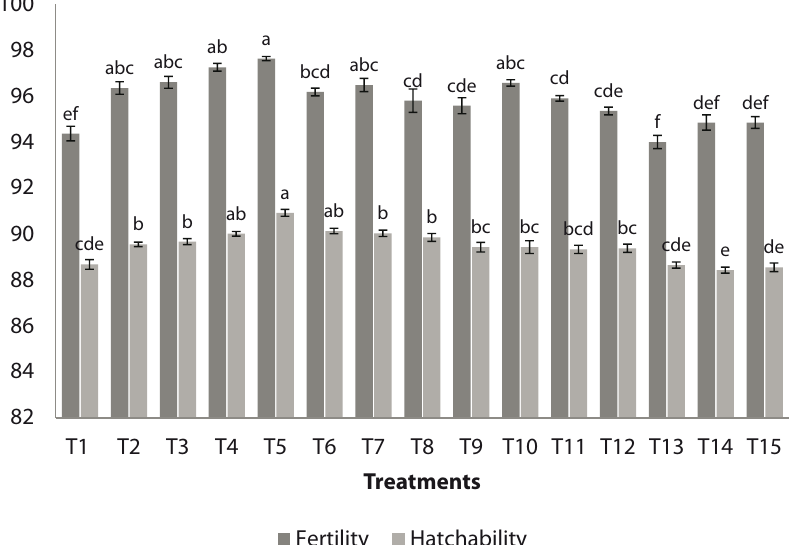
Treatments Fertility Hatchability For both fertility and hatchability, different letters indicate significant differences ( P< 0.05) between treatments. Effect of feeding time and frequency on the mean ( ± SE) of the reproductive performance